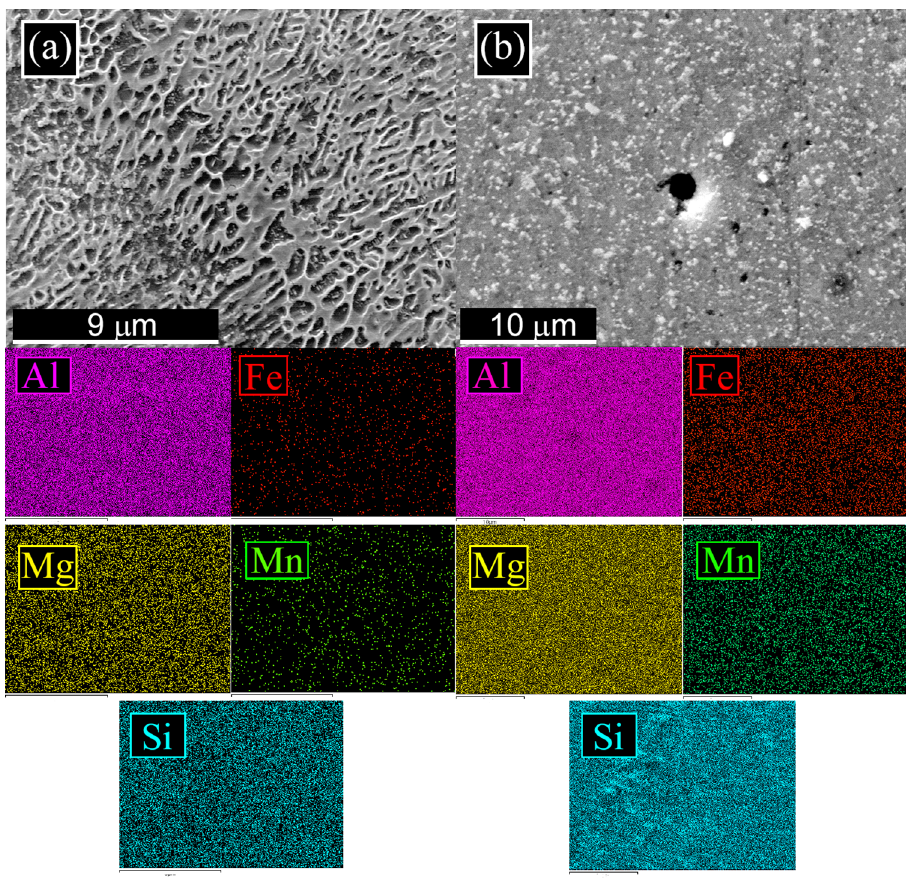
Figure 3. Scanning electron microscope (SEM) images with EDS elemental maps of the as printed sample ( a ) and of the annealed sample ( b ) to highlight the distribution of the elements on the